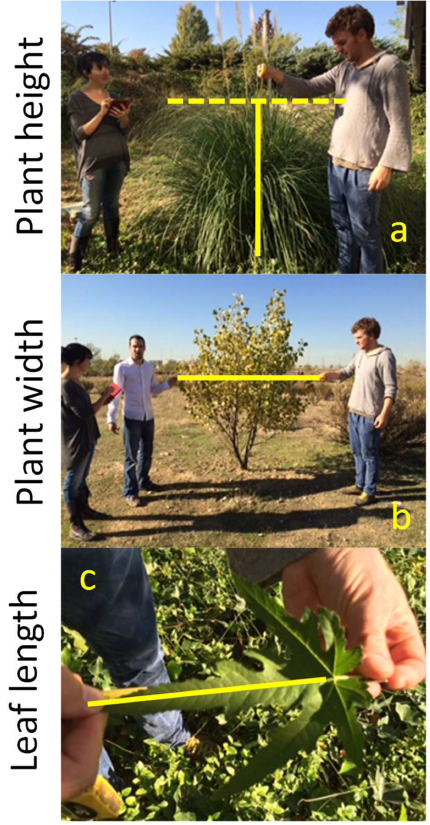
Figure 11. Measuring plant height (a) , plant width (b) and leaf length (c) in the field. Photographs by Miguel Berdugo.